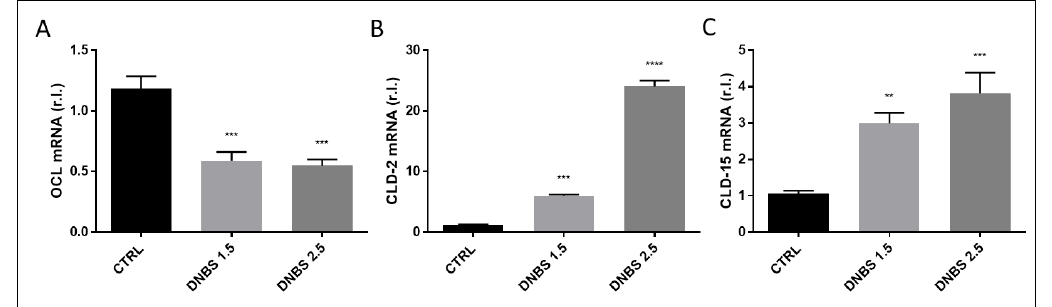
Figure 2. DNBS-induced impaired tissue permeability. Colon from C57BL/6 was cultivated for 5 h in a GEVS and untreated (CTRL) or treated with the indicated concentrations of DNBS and tissue permeability was evaluated by measuring the mRNA levels of tight junction (TJ) components, ( A ) Occludin (OCL), ( B ) Claudin-2 (CLD2) or ( C ) Claudin-15 (CLD15), by qPCR. Histograms represent mean ± SD of triplicate sample; **** p < 0.0001; *** p < 0.001; ** p < 0.01.